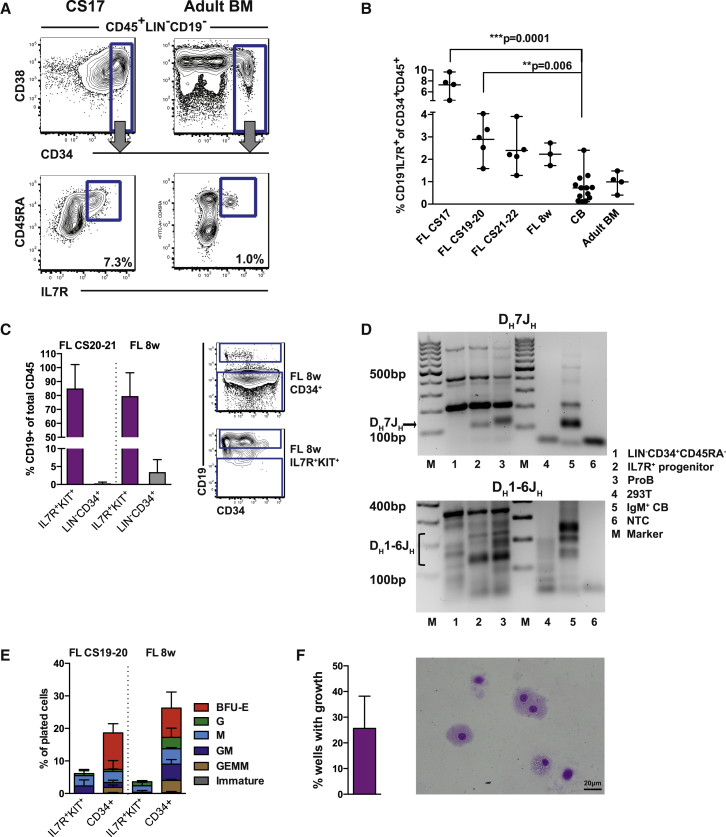
Identification of a CD19–IL-7R+ Progenitor(A) Fluorescence-activated cell sorting (FACS) analysis of CS17 FL showing CD19−IL-7R+ progenitor co-expressing CD34 and CD45RA. Adult BM (right) is shown for comparison. Cells were gated CD45+LIN−CD19–. Further gating as indicated. Mean percentage of total CD45+CD34+ cells.(B) Kinetics of IL-7R progenitor emergence during development as percentage of total CD45+CD34+ cells. Each dot represents one biological sample. Mean with range. Statistical comparison versus CB control.(C) B cell potential of IL-7R+KIT+ FL progenitors was tested by co-culture on MS-5 for 2 weeks. Percentage of CD19+ B cells of total CD45+ cells is shown (left) with representative FACS analysis (right). CD34+ cells were used as control. Mean ± SD, n = 2–3.(D) Agarose gel of IGH DJ rearrangements in IL-7R+ FL progenitor. Top: DH7JH recombination assay. Bottom: DH1-6JH recombination assay. Label for lanes 1–6 is shown to the right. Marker lanes (M). Predicted DH7JH recombination between 100 and 130 bp. Predicted DH1-6JH rearrangements between 110 and 290 bp, n = 1 (van Dongen et al., 2003).(E) GM and erythroid potential of IL-7R+KIT+ FL progenitor in semi-solid media. Data show distribution of colony types as percentage of plated cells versus CD34+ cells as controls. Mean ± SD, n = 2 per developmental stage.(F) Myeloid potential of IL-7R+KIT+ FL progenitor in liquid culture (20–40 cells/well). Graph shows percentage of wells expanded to >50 cells (left). Cytospin of macrophages generated from FL IL-7R+KIT+ progenitor (right). Mean ± SD, n = 3.See also Figure S2.